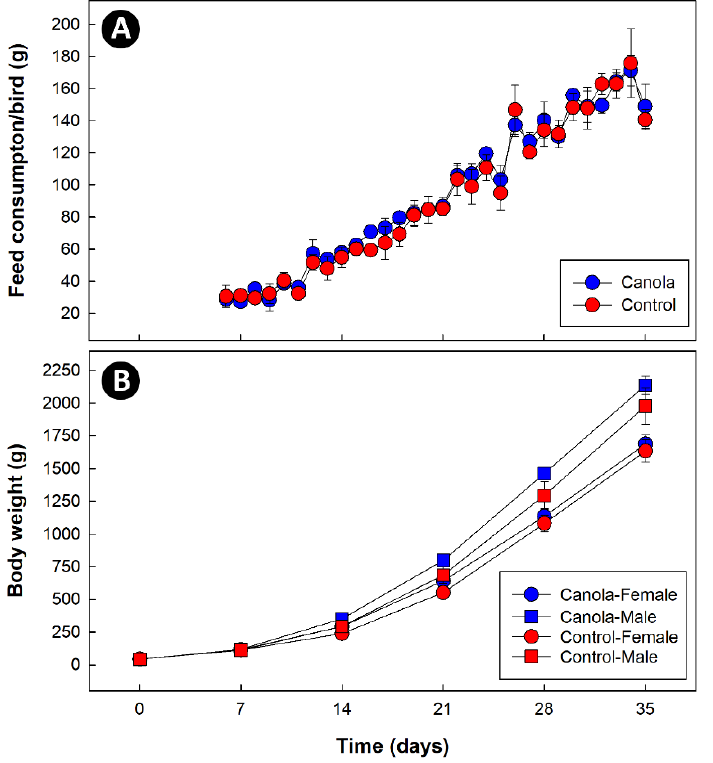
Figure 1. ( A ) Temporal feed consumption (g/bird/d) of broilers fed a diet supplemented with canola meal (20%) relative to a control diet. Feed consumption increased ( p < 0.001) over time, but there was no difference ( p = 0.514) between the diet treatments. ( B ) Temporal change in body weights (g) of female and male broilers fed a diet with canola meal (20%) relative to a control diet. Increases in the body weights of female and male birds differed over time ( p < 0.001), and male birds were heavier ( p ≤ 0.008) than female birds at day 21. There was no effect ( p = 0.118) of the diet treatment on body weights.